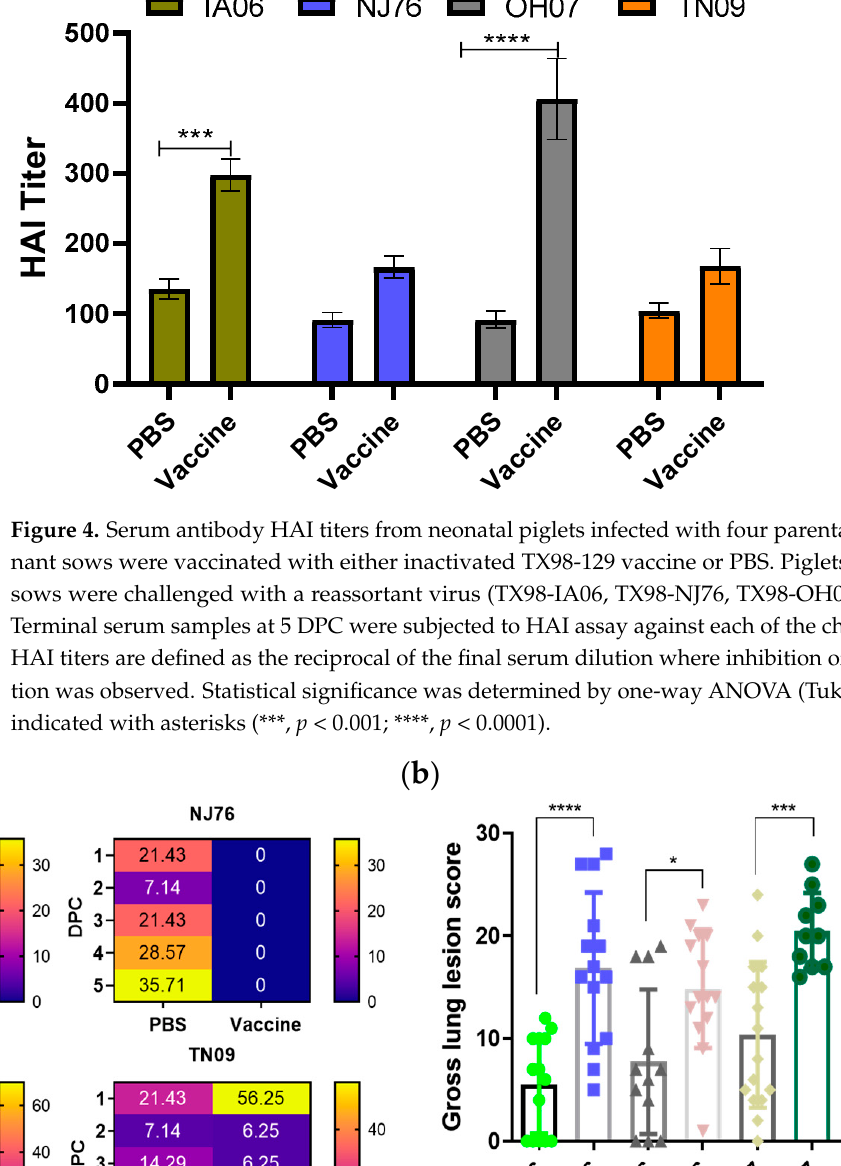
Figure 4. Serum antibody HAI titers from neonatal piglets infected with four parental viruses. Preg- piglets still had fever at 5 DPC). A similar pattern was also observed in the TX98-TN09 nant sows were vaccinated with either inactivated TX98-129 vaccine or PBS. Piglets born from the group (Figure 5a). At necropsy, lung evaluation showed that there were significantly lower sows were challenged with a reassortant virus (TX98-IA06, TX98-NJ76, TX98-OH07, TX98-TN09). gross lesion scores in piglets from vaccinated sows than those piglets from unvaccinated Terminal serum samples at 5 DPC were subjected to HAI assay against each of the challenge viruses. sows after challenge with each of the reassorted parental viruses (Figure 5b). HAI titers are de fi ned as the reciprocal of the fi nal serum dilution where inhibition of hemaggluti- nation was observed. Statistical signi fi cance was determined by one-way ANOVA (Tukey’s test) and